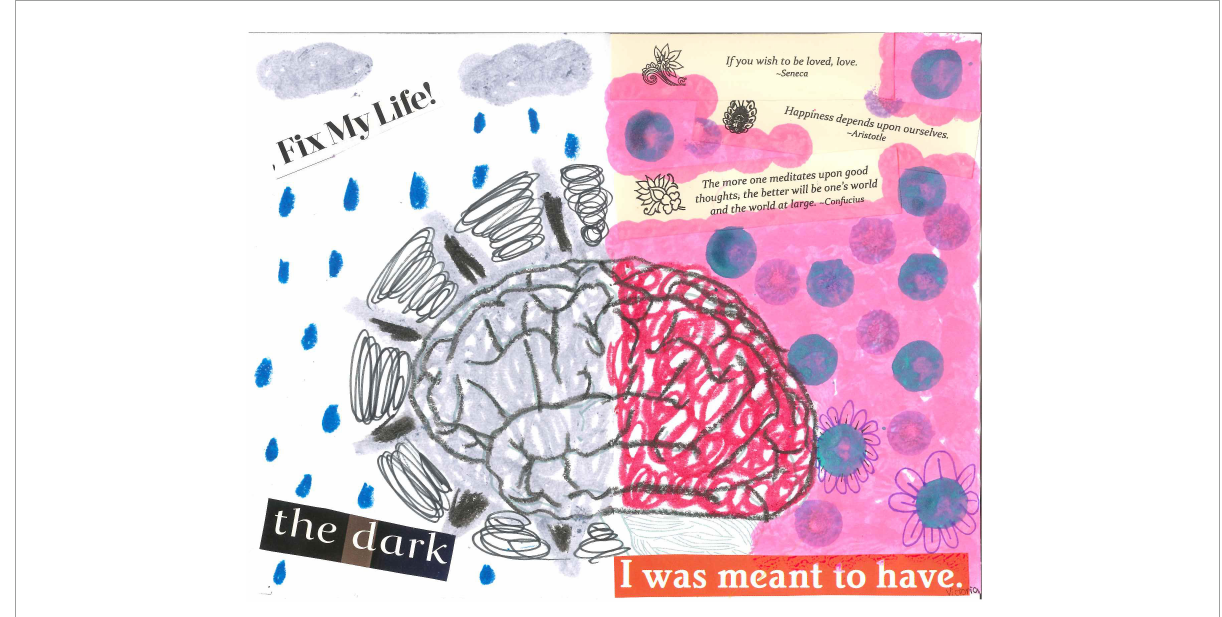
FIGURE2 Art created by one of the participants in the art therapy workshop